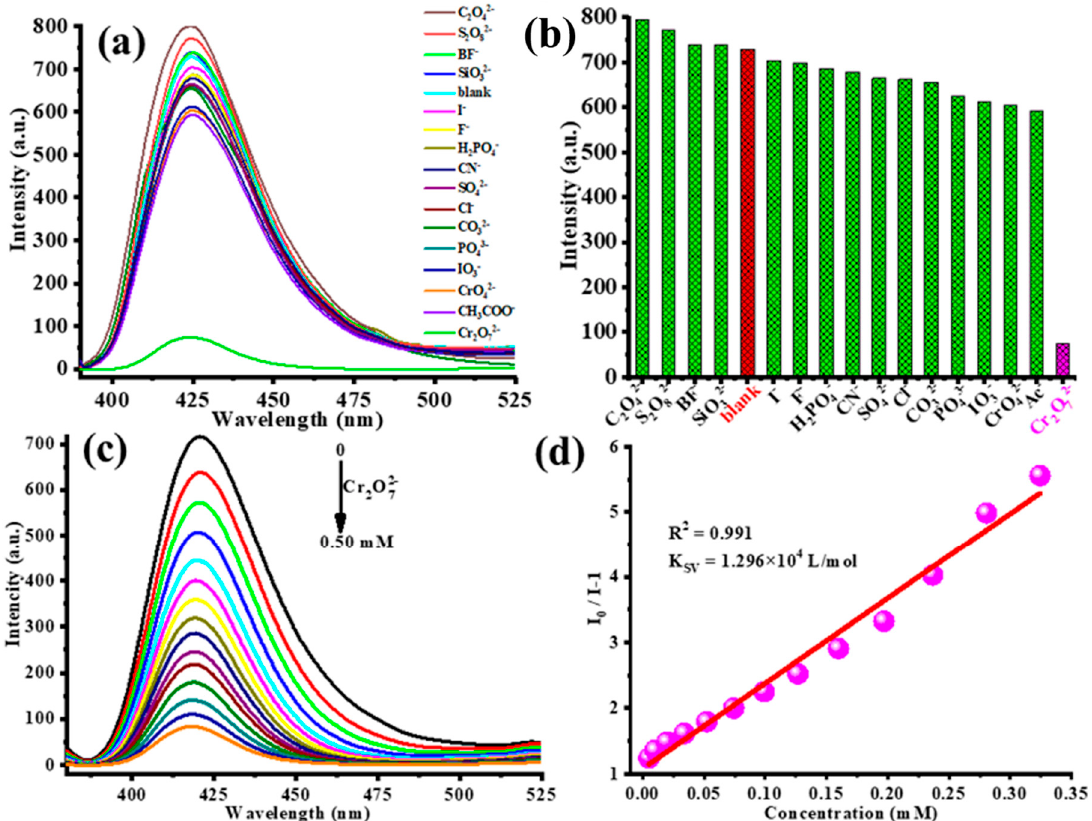
Figure 11. ( a ) Photoluminescence spectra of 1 in water and aqueous solutions containing different anions (1 × 10 − 3 M) when excited at 376 nm. ( b ) The photoluminescence intensities of 1 in aqueous solutions with various anions (1 × 10 − 3 M) when excited at 376 nm. ( c ) The emission spectra for 1 in aqueous solution of different Cr 2 O 72 − concentrations. ( d ) The linear relationships for 1 in aqueous solution of different Cr 2 O 72 −